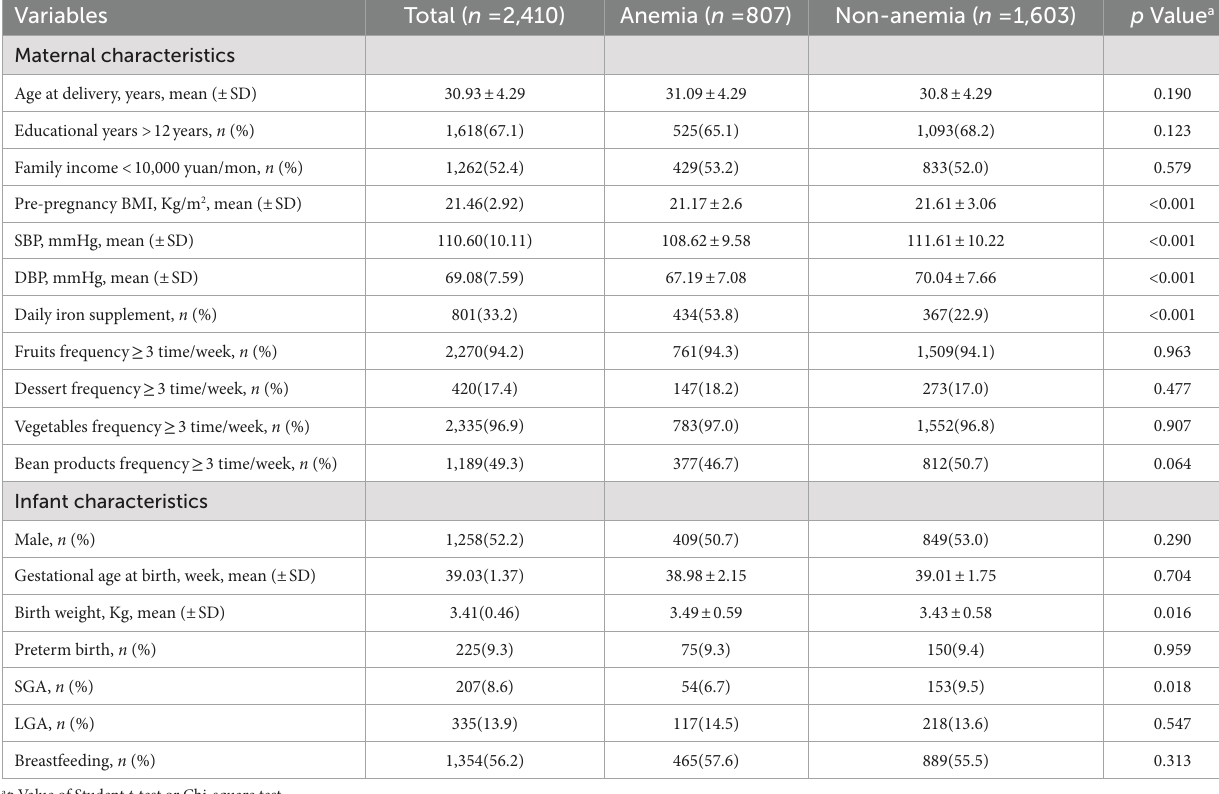
TABLE 1 Characteristics of the 2,410 mother–child pairs in this analysis.